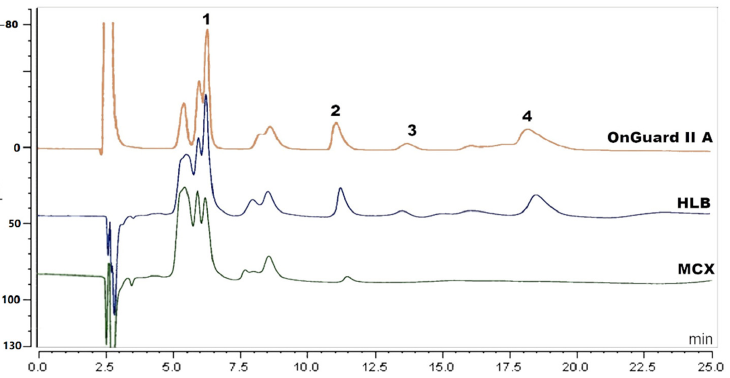
Figure 2. Chromatogram of sample solution pretreated by MCX, HLB and OnGuard II A cartridge. Peak 1: sodium, peak 2: potassium, peak 3: magnesium and peak 4: calcium.